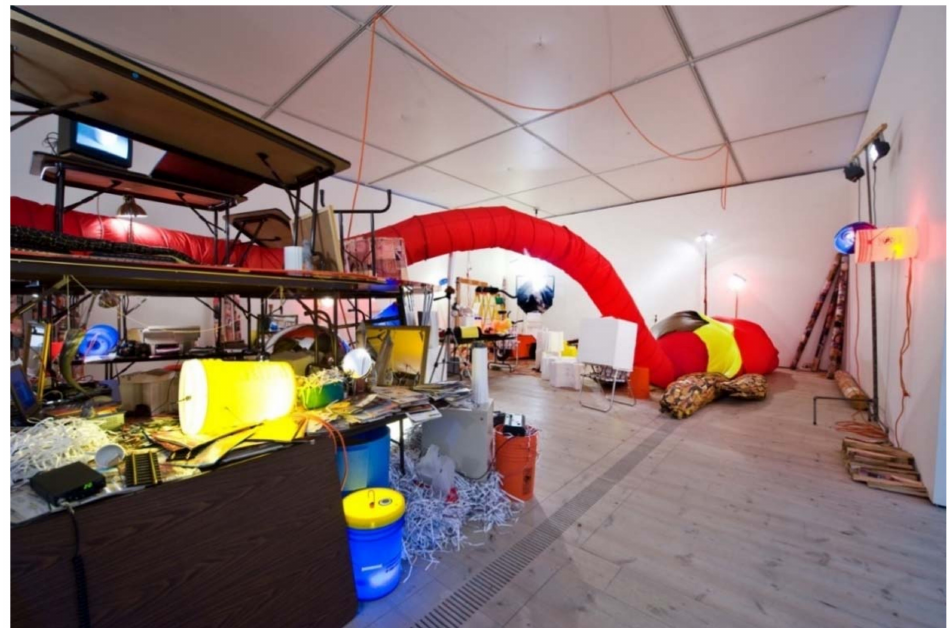
Figure 2. Jason Rhoades, The Creation Myth , 1998 / 2015. Installation view. BALTIC Centre for Contemporary Art, Gateshead, UK. Friedrich Christian Flick Collection, Berlin. Photo: Colin Davison. © 2015 BALTIC Centre for Contemporary Art. Used by permission.